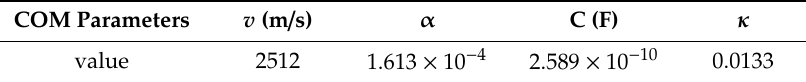
Figure 11. The COM model of the sensing device patterned by a one-port resonator. For simulation of the one-port resonator configuration, composed of one IDT and two adjacent shortened grating reflectors (Figure 11), the COM model was used to analyze the IDT and reflectors reflectively. By using the cascading mixed P-matrix of the IDT, reflectors, and cavity between the IDT and adjacent reflectors, the frequency response S 11 can be expressed by 11